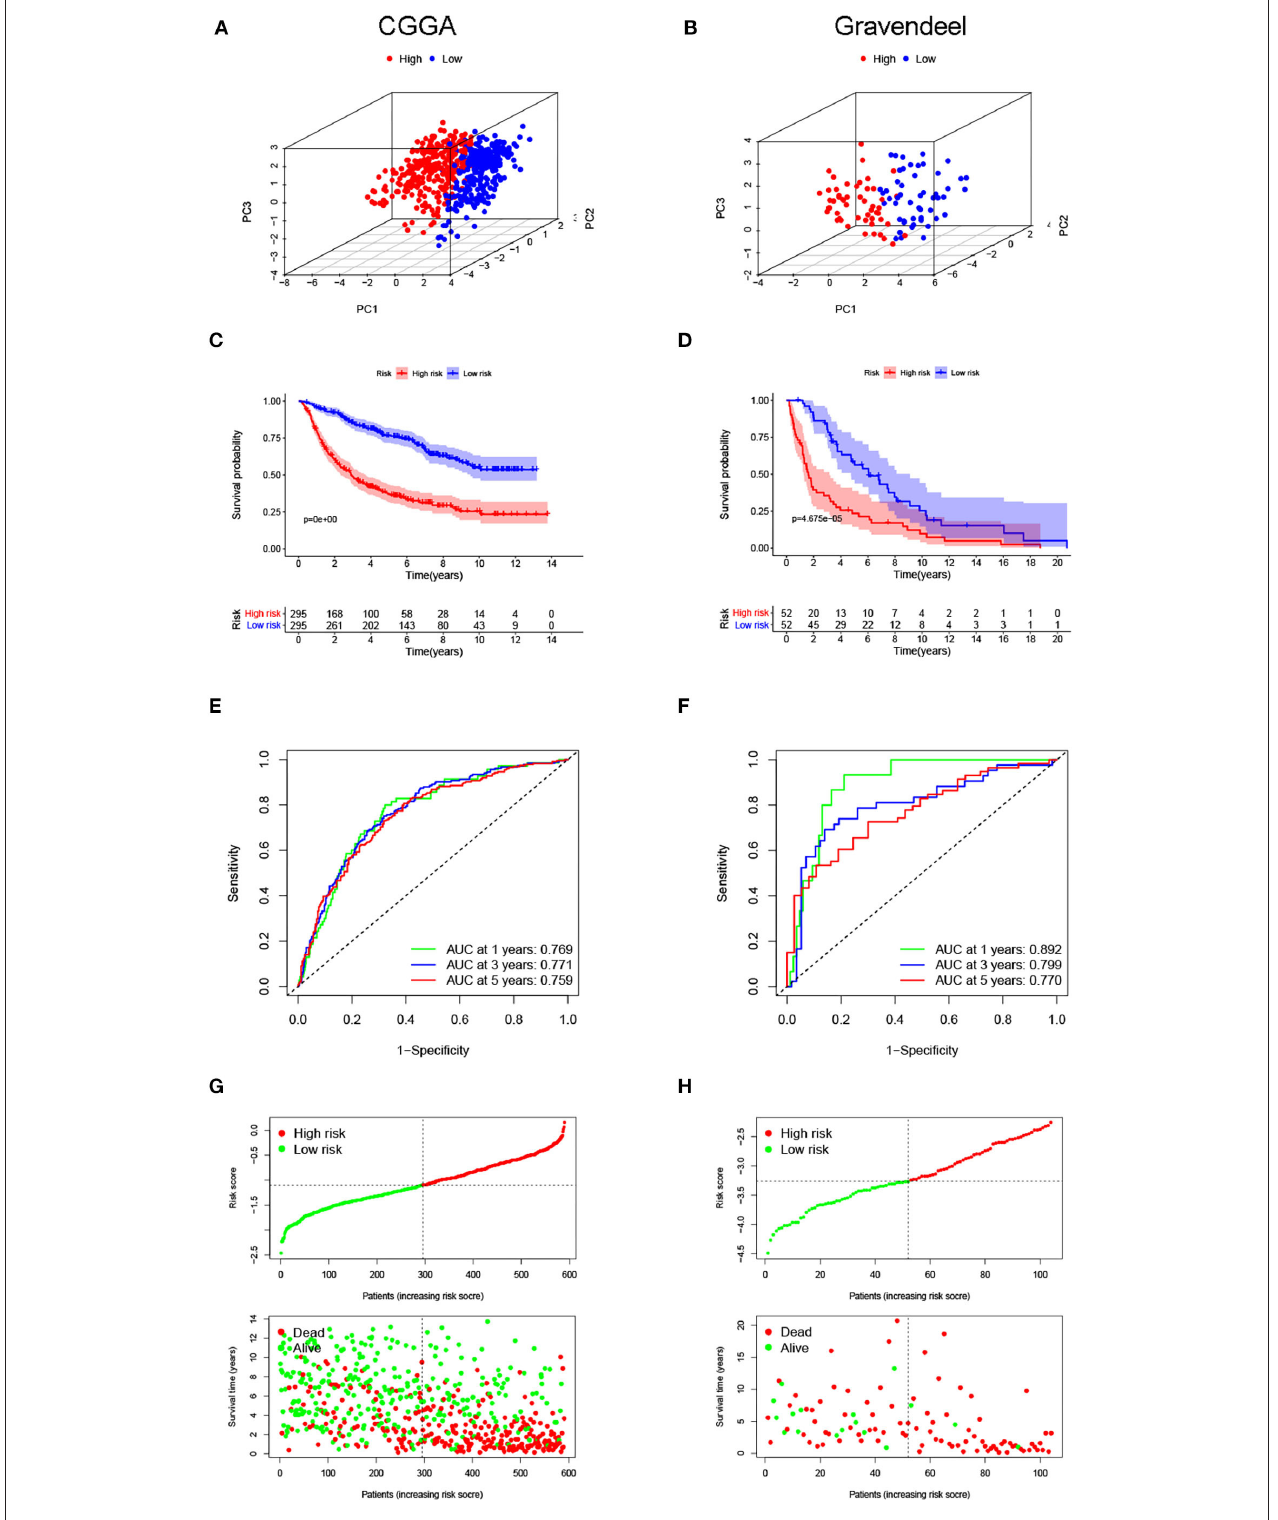
FIGURE 3 | Evaluated predictive value of the risk signature in the validation cohorts. Principal component analyses (PCAs) for the (A) Chinese Glioma Genome Atlas (CGGA) and (B) Gravendeel cohorts. (C,D) Kaplan–Meier curves for survival in the validation cohorts. (E,F) Time-dependent ROC curves are used to assess the prediction accuracy. (G,H) Distribution plots of the risk score, survival status, and survival time in the validation cohorts.